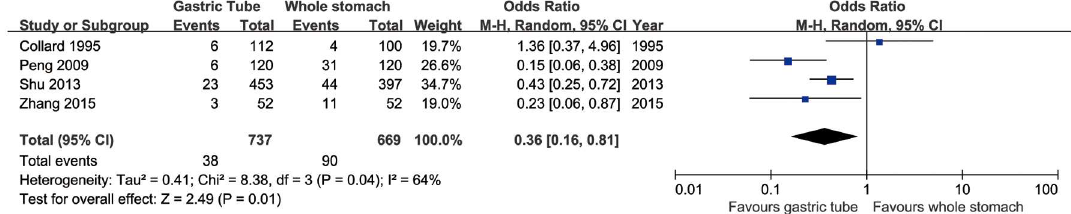
Fig 4. Forest plot of reflux esophagitis in the whole-stomach and gastric-tube groups.